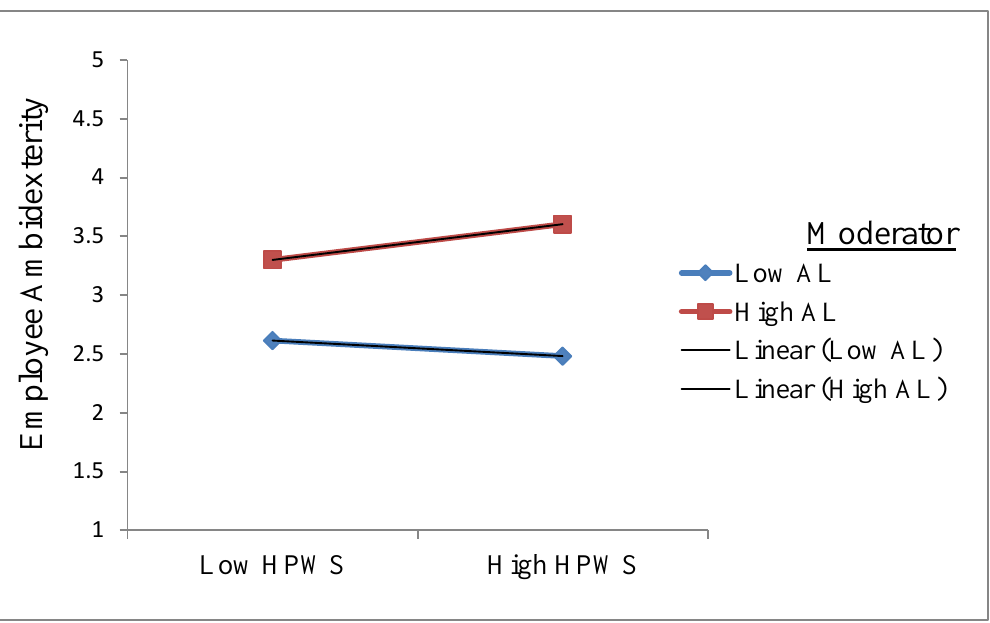
Figure 3. Moderating Effect of Ambidextrous